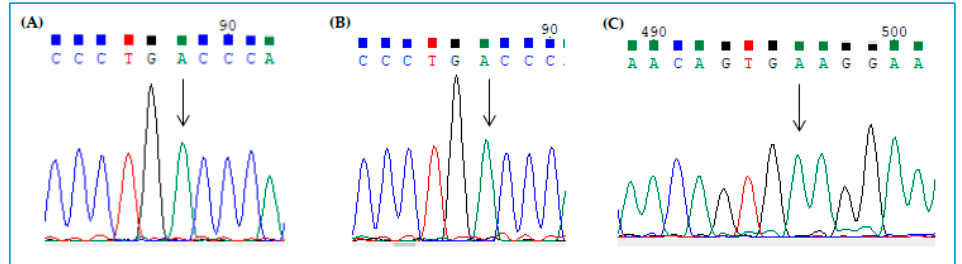
Figure 9. Electropherograms of sequenced H2BGFP opal and CFTR W1282X amplicons from cells expressing ( A ) GFP g RNA 50–34, ( B ) GFP g RNA 50–35, ( C ) CFTR g RNA 50–34. Mutant positions are indicated by the arrows.